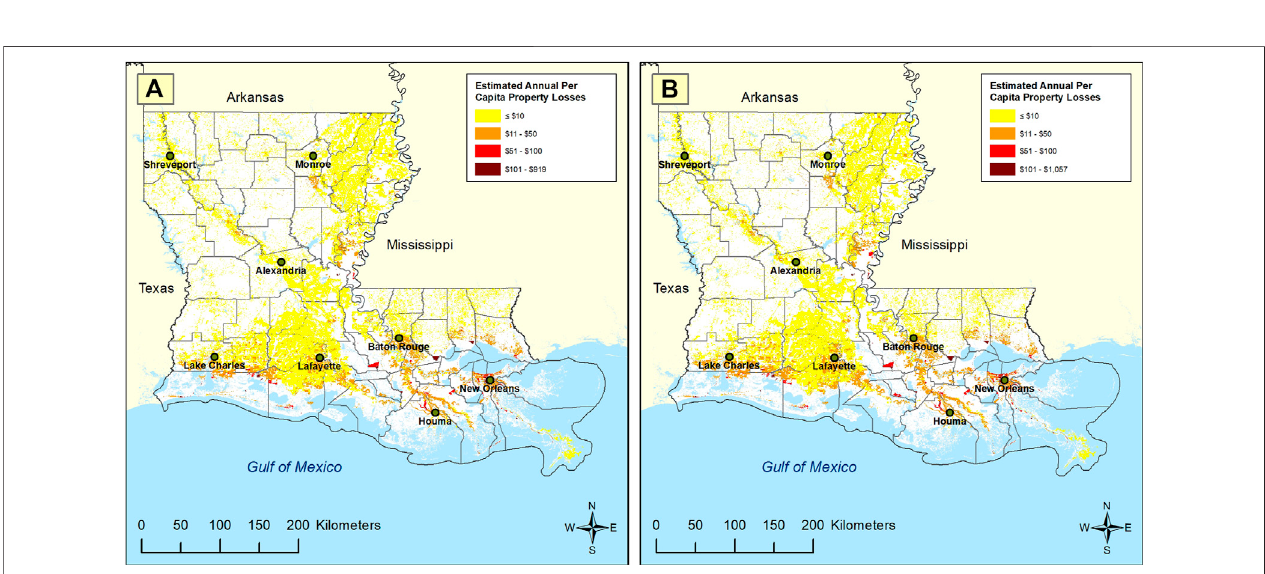
FIGURE 4 | Estimated annual per capita property loss (2010$) due to expansive soil by Louisiana census block: (A) historical, and (B) projection for 2050.